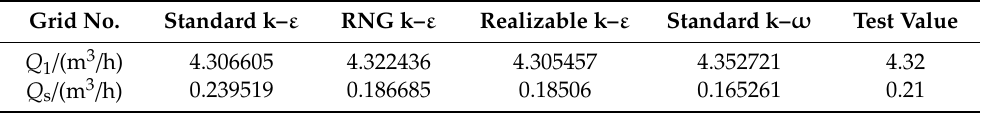
Table 3. Numerical and experimental results with different turbulence models under P 1 = 350 kPa and P 2 = 100 kPa flow conditions.